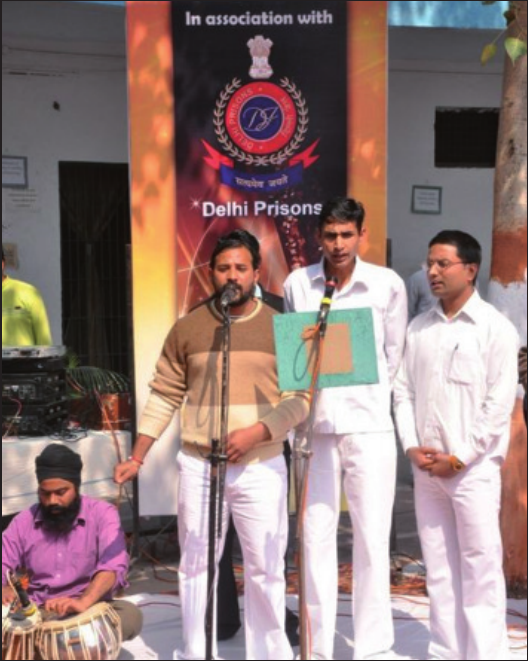
Figure 8 Cultural programme at Tihar Central Jail Courtesy: Tihar Central